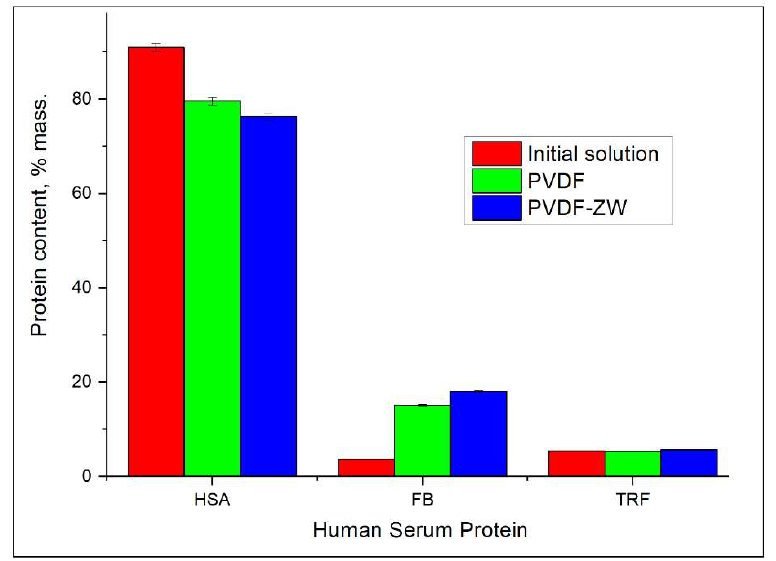
Figure 5. Comparison between protein composition in initial solution and in proteins adsorbed on the membrane surface.